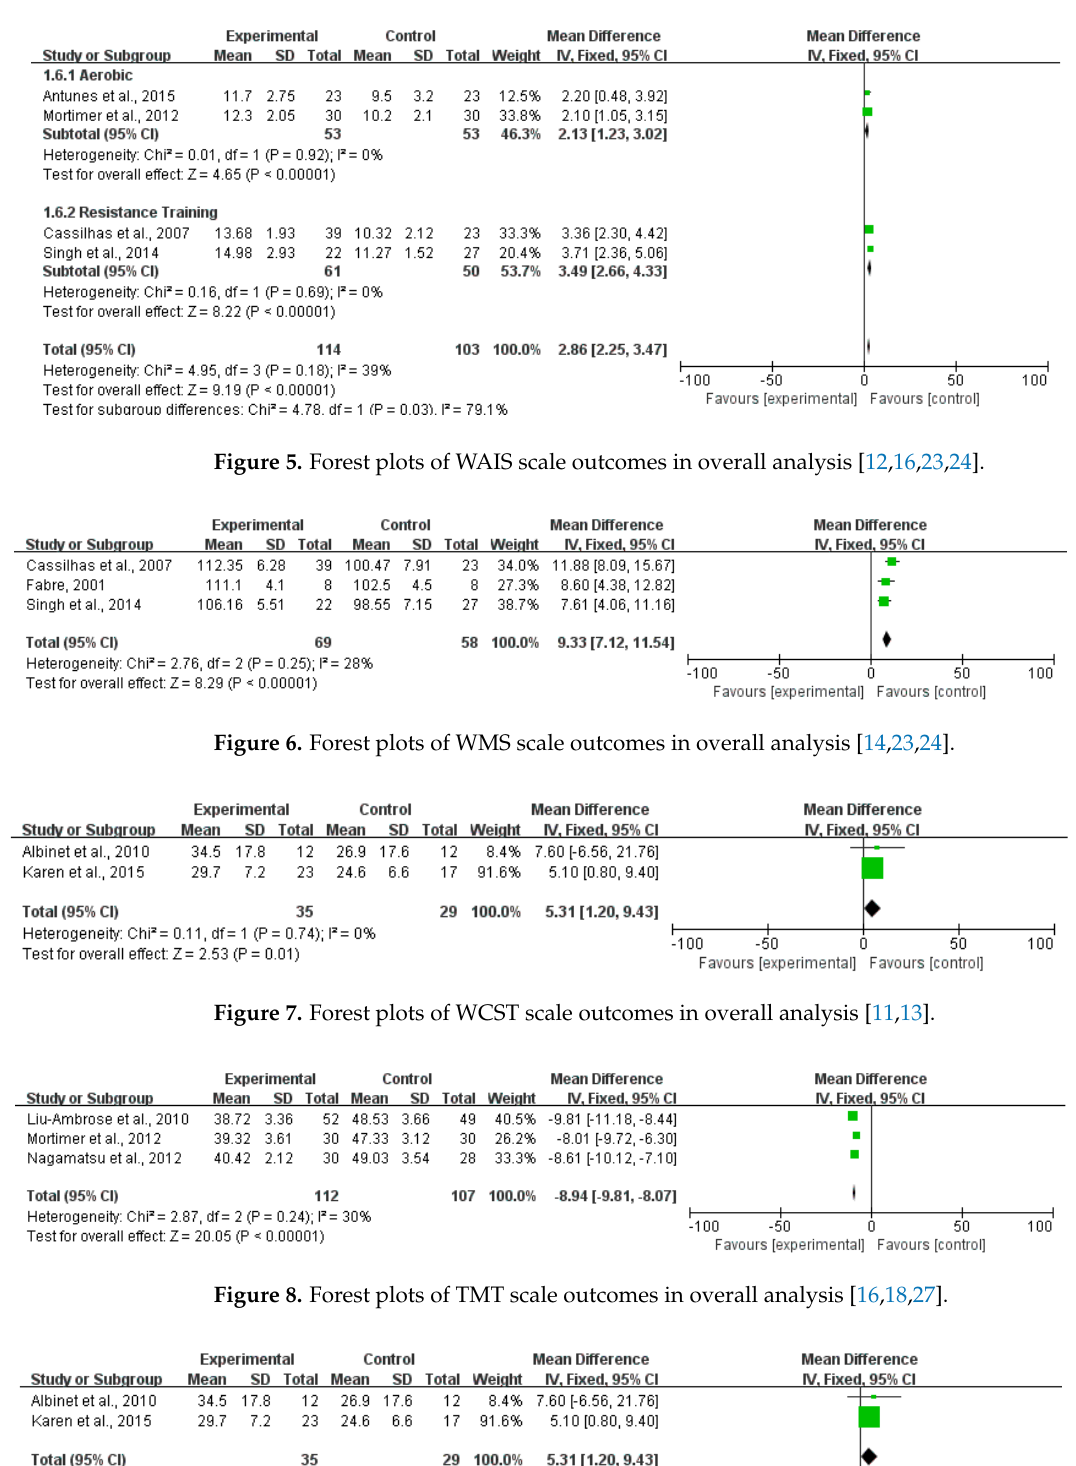
Figure 9. Forest plots of SCWT scale outcomes in overall analysis [11,13].